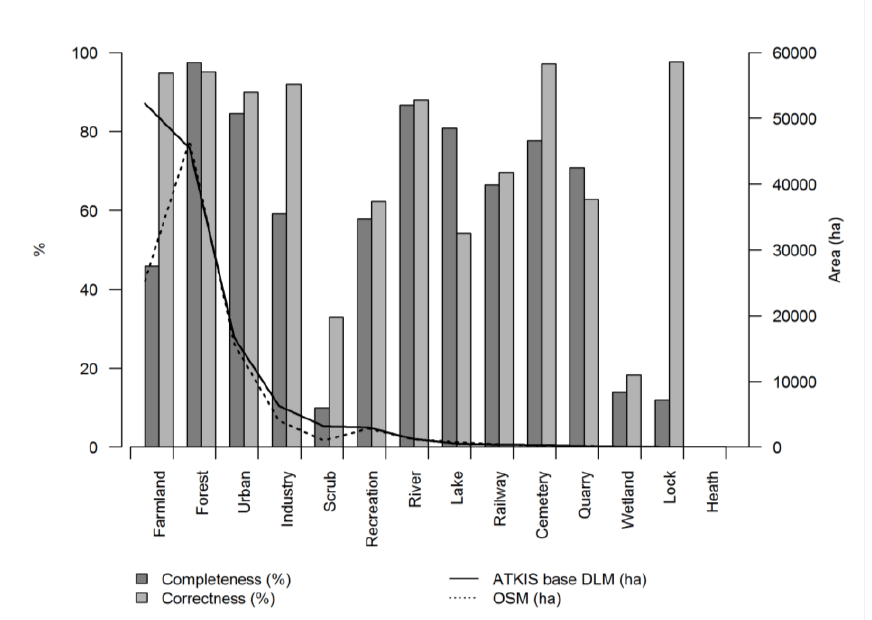
Figure 3. Completeness and correctness of the OSM dataset in comparison to the reference data set ATKIS Base DLM. The lines show the coverage in hectare.